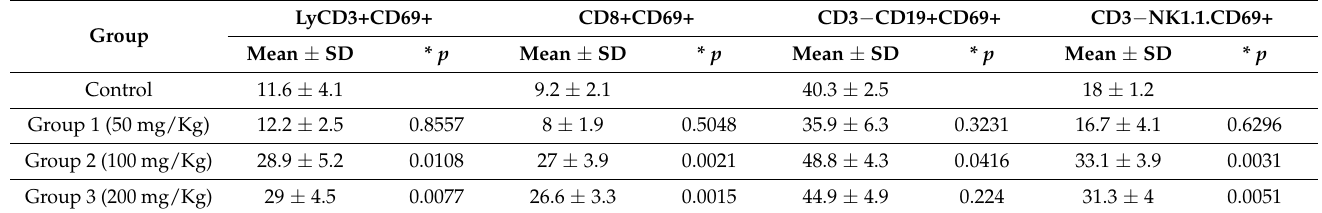
Table 12. The effect of administering ImunoBoost in three different concentrations on the expression of the CD69 marker on lymphocyte surfaces in mice—stimulation with LPS; * p = p